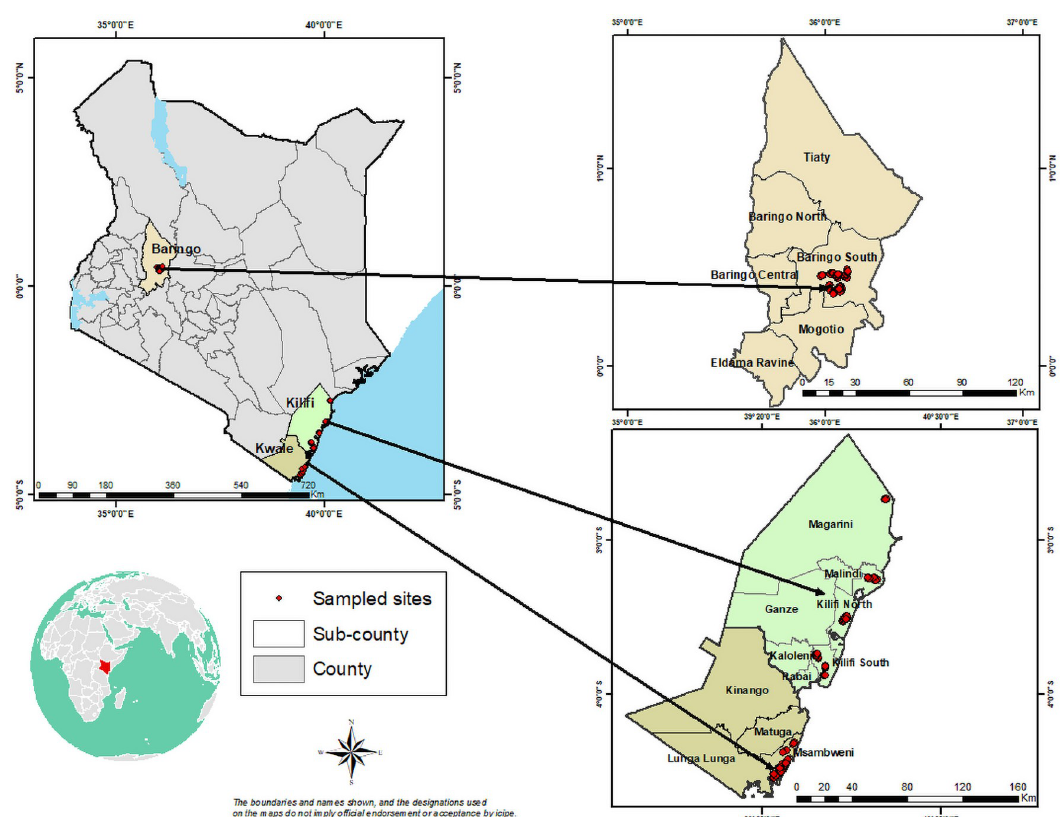
Fig 1. Study area and sampled households: Emily Kimathi, GIS unit, icipe; The map was developed using the QGIS 3.16 software, https://qgis.org/en/site/forusers/download.html.